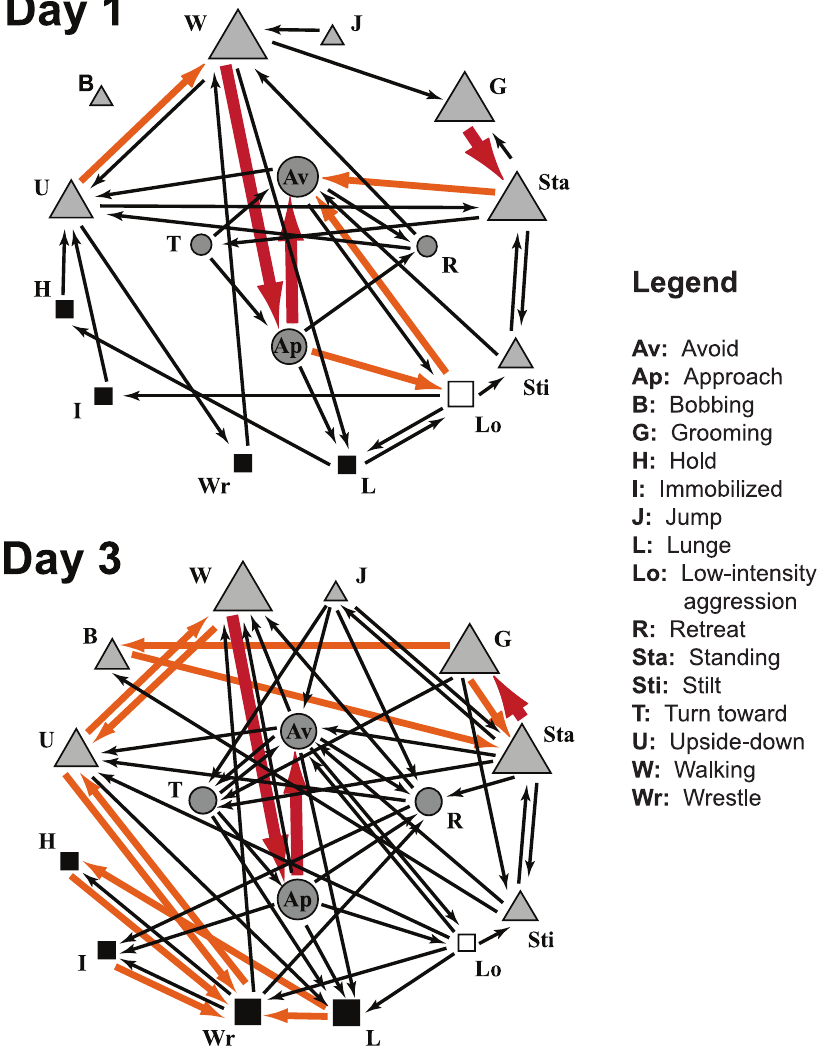
Figure 10. Statistically significant behavioral transitions at 1 and 3 days of age. Kinematic diagrams illustrating behavioral transitions that occurred more often than predicted by chance on days of age 1 and 3. Arrows indicate the direction of the transition. Three levels of arrow thickness, from smallest to largest, denote the degree of departure from randomness based on Freeman-Tukey values of 1–5 (black), 5–10 (orange), and . 10 (red). Closed squares indicate high-intensity aggressive behaviors; open squares, low-intensity aggressive behaviors; triangles, non-interactive behaviors; circles, interactive, non-aggressive behaviors. Five sizes of symbols represent the relative frequency of occurrence of each particular behavior with respect to the entirety of behaviors for that age group: , 1%, 1–5%, 5–10%, 10–15%, and .